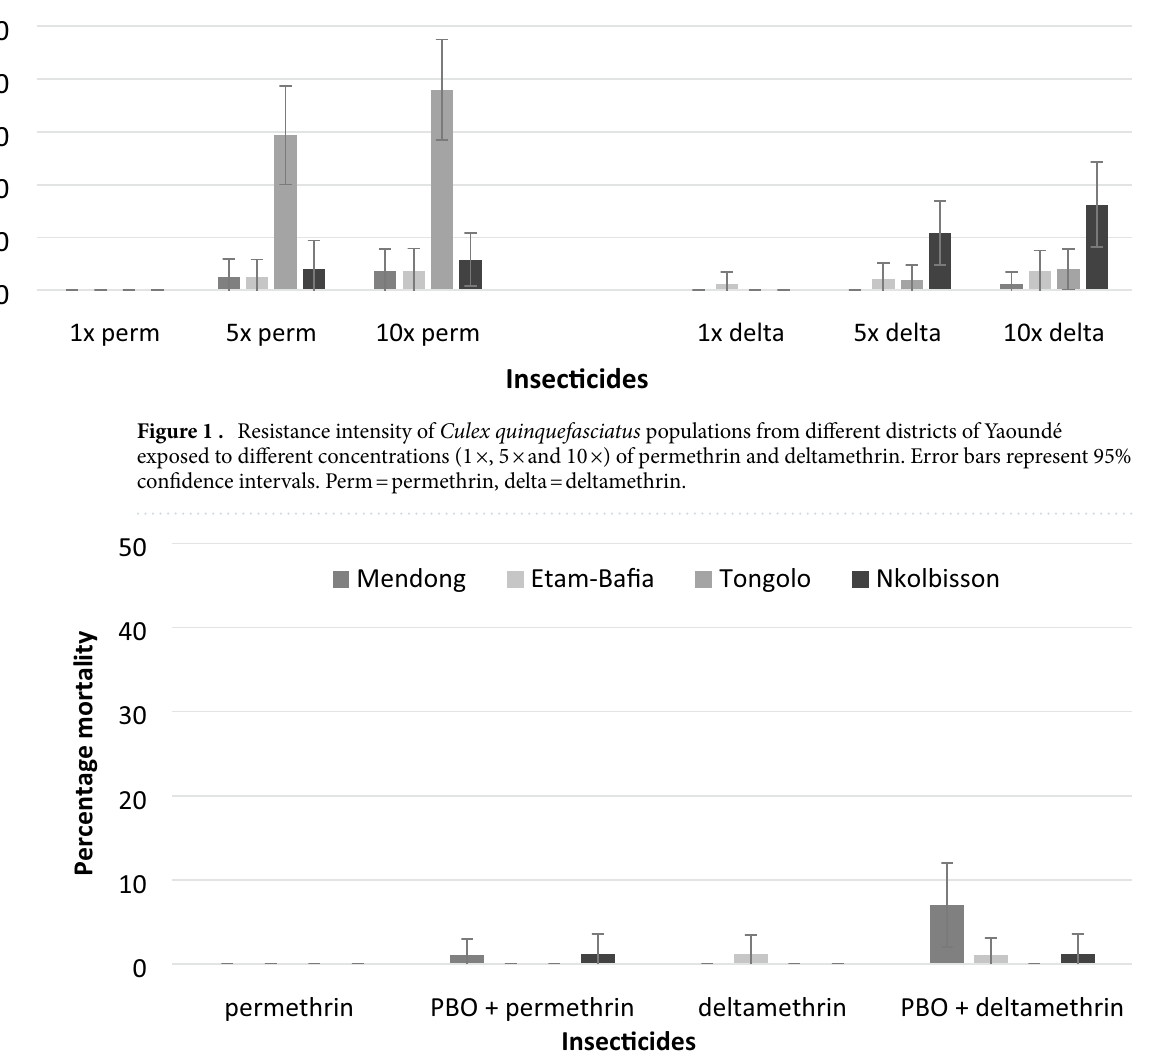
Figure 2. Effects of pre-exposure to 4% PBO on the susceptibility level of Culex quinquefasciatus to permethrin (1 ×) and deltamethrin (1 ×) in the city of Yaoundé. Error bars represent 95% confidence